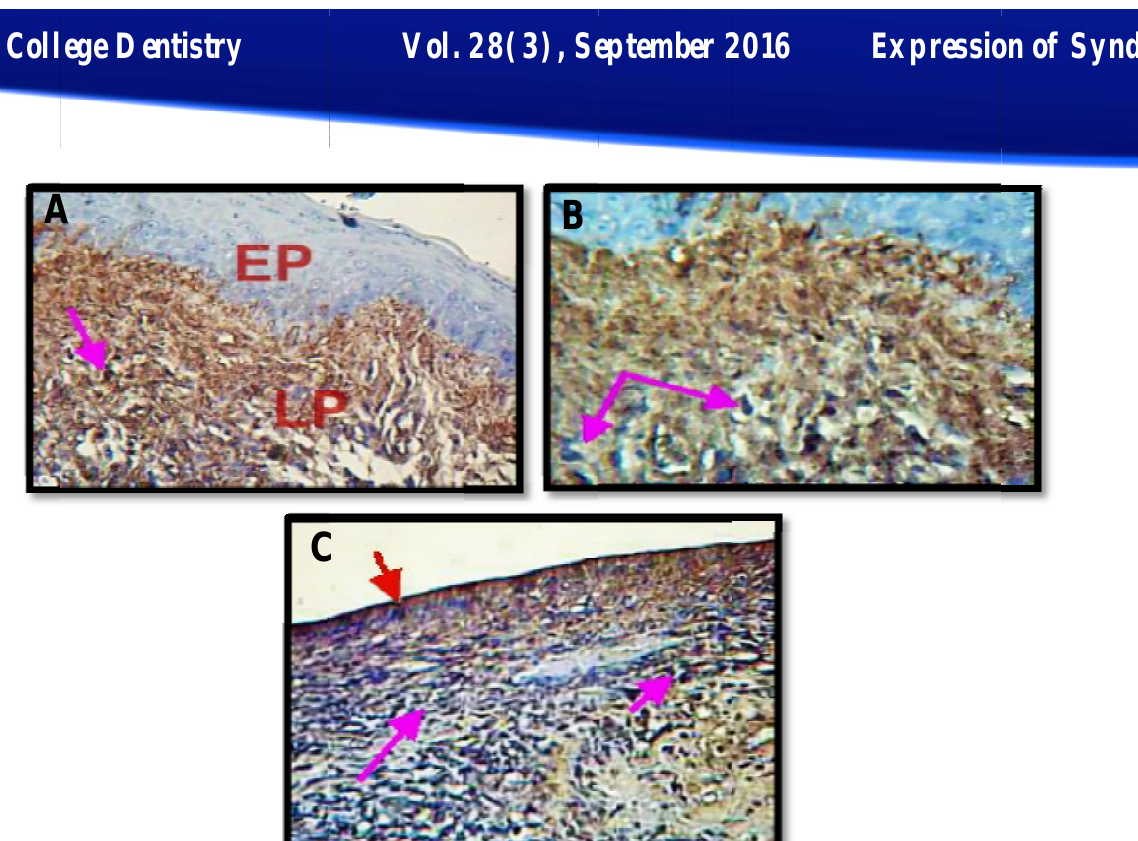
Figure 2 2: experimental group (normal saline) with immunohistochemical expression of syndecan experimental group (normal saline) with immunohistochemical expression of syndecan experimental group (normal saline) with immunohistochemical expression of syndecan experimental group (normal saline) with immunohistochemical expression of syndecan experimental group (normal saline) with immunohistochemical expression of syndecan experimental group (normal saline) with immunohistochemical expression of syndecan experimental group (normal saline) with immunohistochemical expression of syndecan experimental group (normal saline) with immunohistochemical expression of syndecan 1 (DABStain). ( 1 (DABStain). (A) At 3 A) At 3 rd day, Epithelial cell (EP) of gingiva of saline group shows negative day, Epithelial cell (EP) of gingiva of saline group shows negative day, Epithelial cell (EP) of gingiva of saline group shows negative day, Epithelial cell (EP) of gingiva of saline group shows negative day, Epithelial cell (EP) of gingiva of saline group shows negative day, Epithelial cell (EP) of gingiva of saline group shows negative day, Epithelial cell (EP) of gingiva of saline group shows negative expression for syndecan expression for syndecan expression for syndecan -1 ,while lamina properia (LP) shows positive expression by lymphocyte 1 ,while lamina properia (LP) shows positive expression by lymphocyte 1 ,while lamina properia (LP) shows positive expression by lymphocyte 1 ,while lamina properia (LP) shows positive expression by lymphocyte 1 ,while lamina properia (LP) shows positive expression by lymphocyte 1 ,while lamina properia (LP) shows positive expression by lymphocyte 1 ,while lamina properia (LP) shows positive expression by lymphocyte (arrow).DAB stain X20. (B) Magnifying view for lymphocyte cell (arrows) with positive (arrow).DAB stain X20. (B) Magnifying view for lymphocyte cell (arrows) with positive (arrow).DAB stain X20. (B) Magnifying view for lymphocyte cell (arrows) with positive (arrow).DAB stain X20. (B) Magnifying view for lymphocyte cell (arrows) with positive (arrow).DAB stain X20. (B) Magnifying view for lymphocyte cell (arrows) with positive (arrow).DAB stain X20. (B) Magnifying view for lymphocyte cell (arrows) with positive (arrow).DAB stain X20. (B) Magnifying view for lymphocyte cell (arrows) with positive (arrow).DAB stain X20. (B) Magnifying view for lymphocyte cell (arrows) with positive (arrow).DAB stain X20. (B) Magnifying view for lymphocyte cell (arrows) with positive th day, Positive expression of syndecan expression of syndecan sion of syndecan sion of syndecan -1 .DAB stain X40. (C) At 14 1 .DAB stain X40. (C) At 14 1 .DAB stain X40. (C) At 14 th day, Positive expression of syndecan day, Positive expression of syndecan day, Positive expression of syndecan -1 in saline group by sulcular epithelia (red arrow) ,inflammatory cell (pink arrows).DAB stian X20 saline group by sulcular epithelia (red arrow) ,inflammatory cell (pink arrows).DAB stian X20 saline group by sulcular epithelia (red arrow) ,inflammatory cell (pink arrows).DAB stian X20 saline group by sulcular epithelia (red arrow) ,inflammatory cell (pink arrows).DAB stian X20 saline group by sulcular epithelia (red arrow) ,inflammatory cell (pink arrows).DAB stian X20 saline group by sulcular epithelia (red arrow) ,inflammatory cell (pink arrows).DAB stian X20 saline group by sulcular epithelia (red arrow) ,inflammatory cell (pink arrows).DAB stian X20 saline group by sulcular epithelia (red arrow) ,inflammatory cell (pink arrows).DAB stian X20 saline group by sulcular epithelia (red arrow) ,inflammatory cell (pink arrows).DAB stian X20 B A